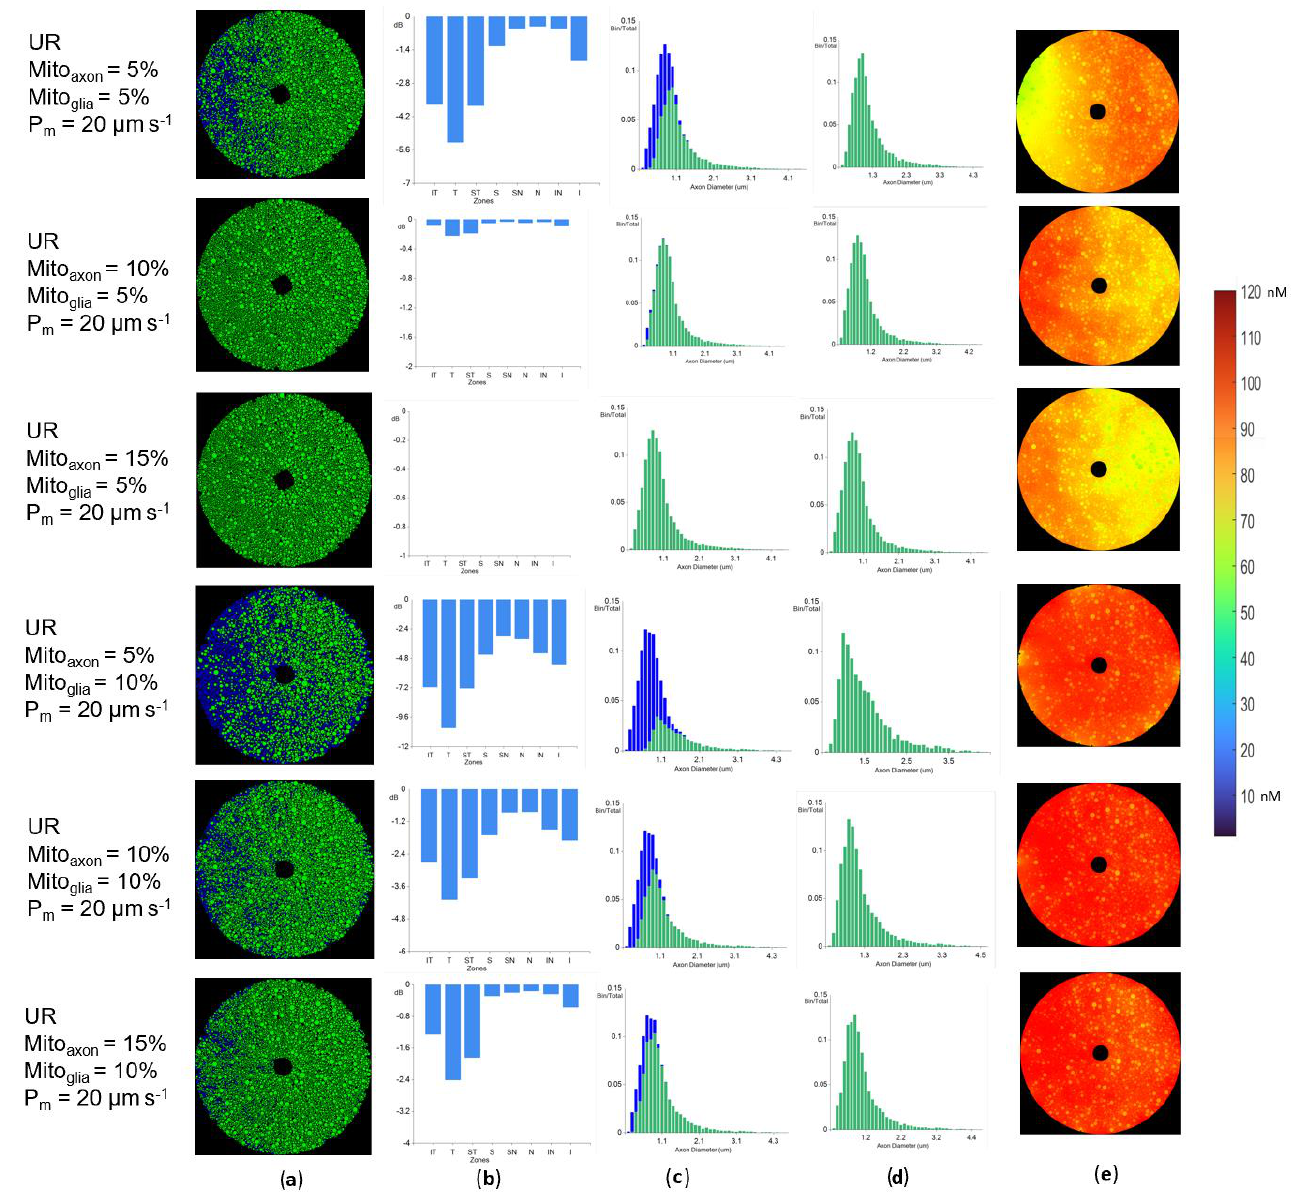
Figure 12. Injury extent and axonal loss distributions in glia-enabled simulations depend on the axonal mitochondrial volume ratios (mito%) and glial mitochondrial volumes: ( a ) Coronal plane view of axonal states at the end of the simulations; ( b ) Coronal plane octant loss, in dB; ( c ) Axonal diameter distributions with details of their state, blue bars for Dead axons and green bars for Healthy ones; ( d ) Histogram of surviving axons diameters; ( e ) Coronal view of the [H 2 O 2 ] at the end of each experiment. Heatmap bar values are in nM.